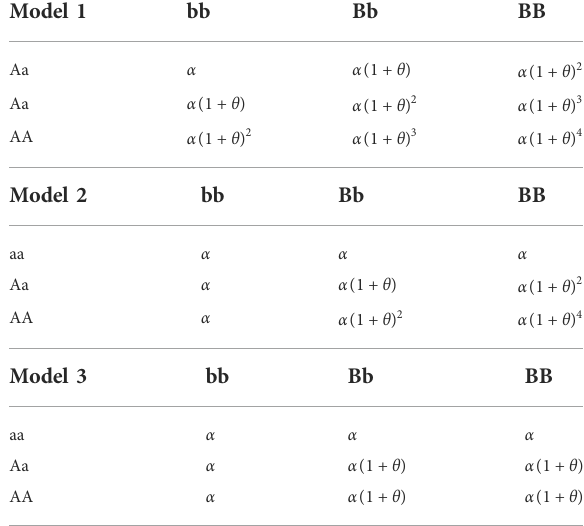
TABLE 2 Two-loci disease